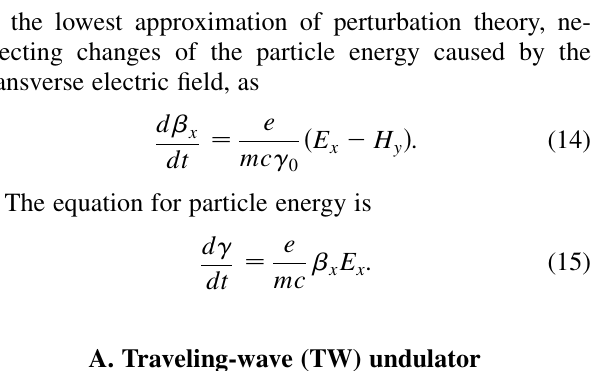
FIG. 1. Parameter K versus undulator period (cid:1) (cid:6) ¼ 10 (cid:5) 14 ; curve 2— (cid:6) ¼ 5 (cid:7) 10 (cid:5) 14 ; and curve 3— (cid:6) ¼ 2 : 5 (cid:7) 10 (cid:5) 13 . The higher (cid:6) indicates the higher electron current density and the smaller beam